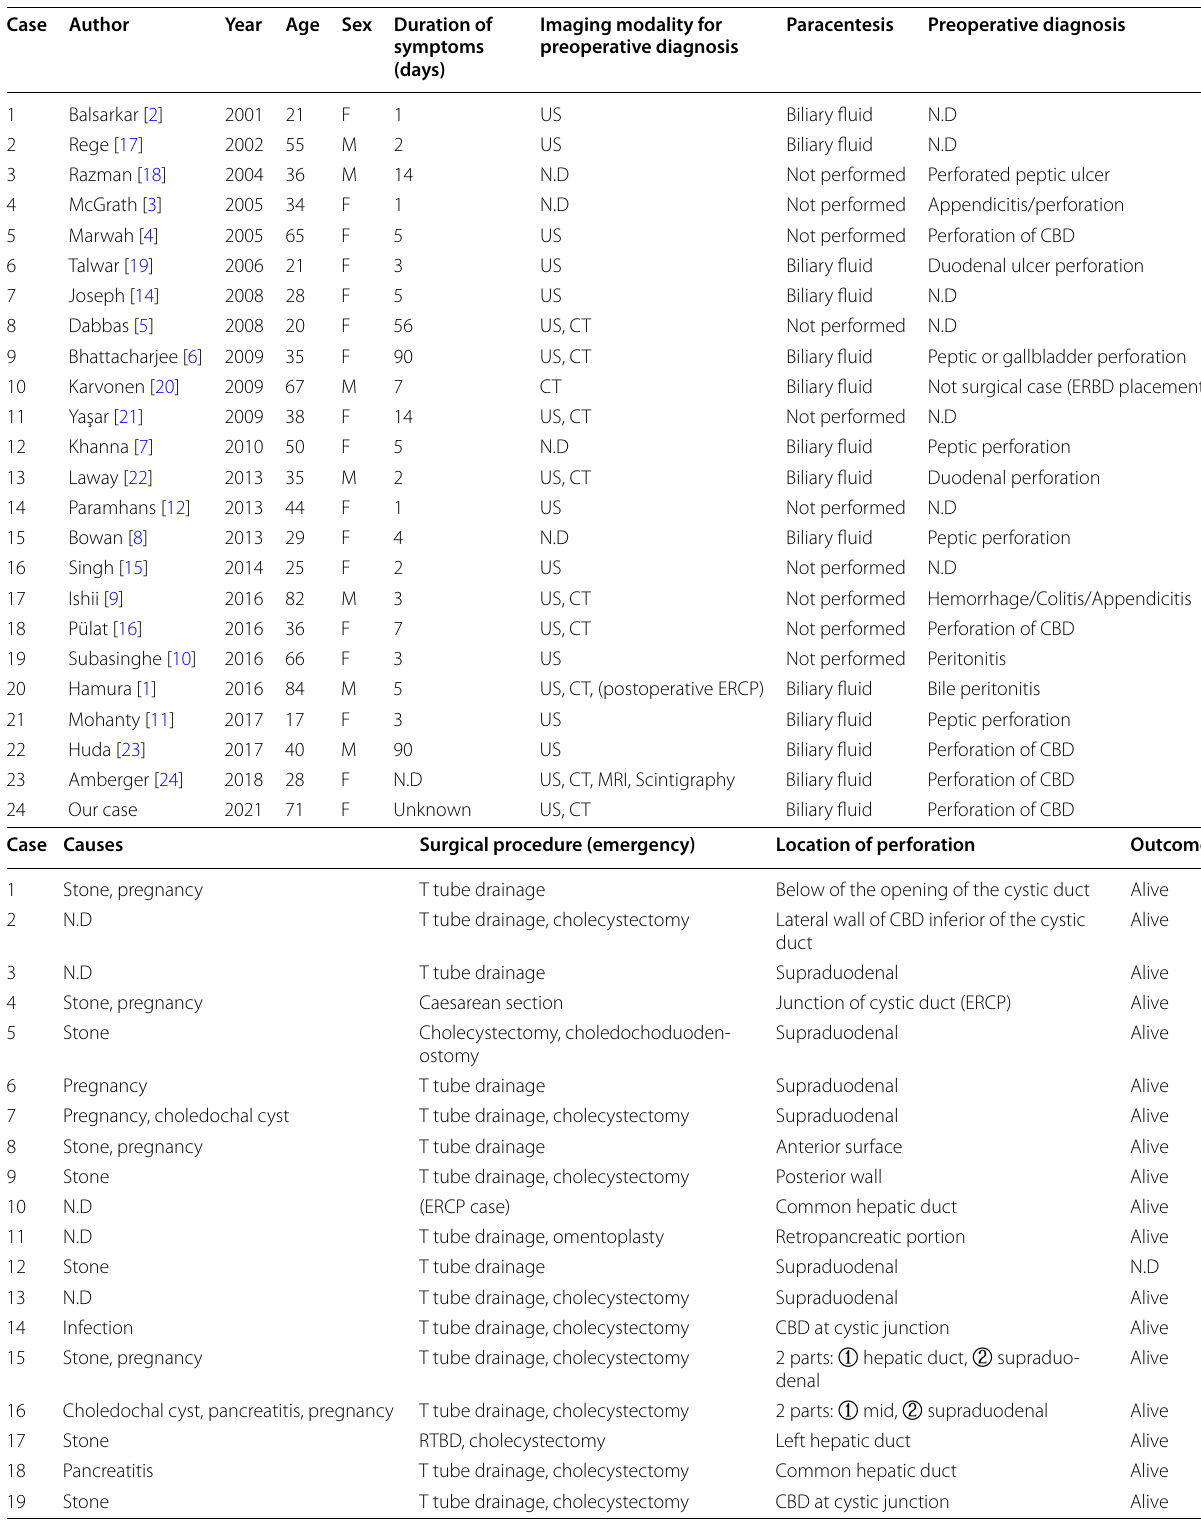
Table 2 Clinical features of 24 case reports (including our case) of spontaneous common bile duct perforation in adults searched from 2001 to